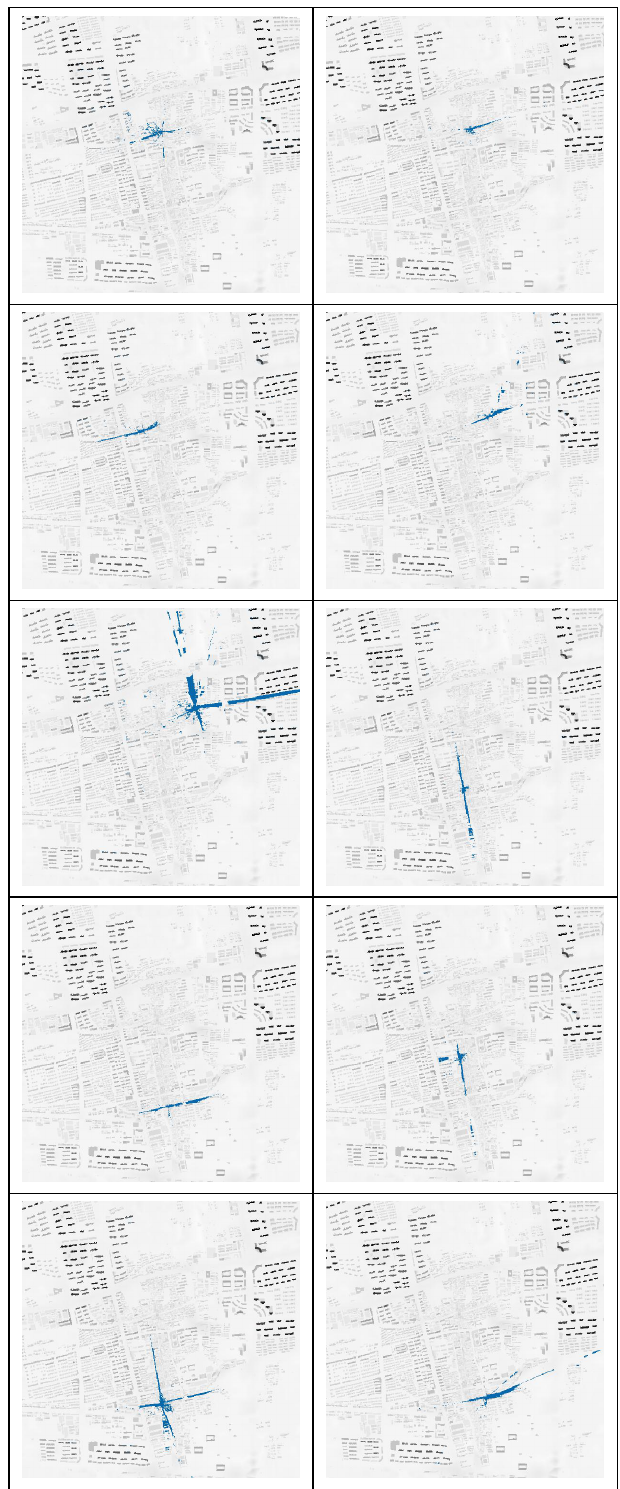
Table 3 . The viewshed maps from historical